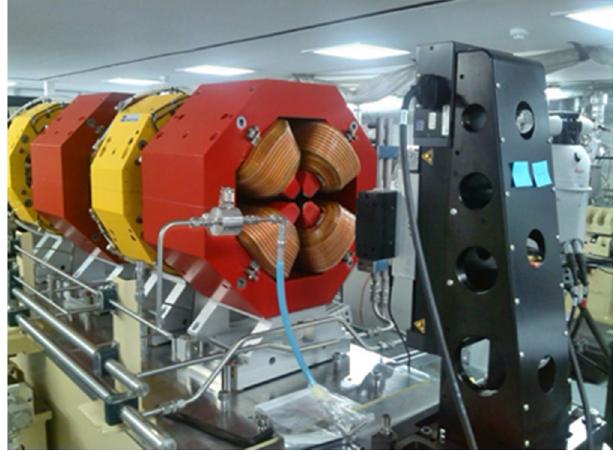
FIG. 8. Alignment of the magnets on the final girder with the stretched wire. One of the two towers of the stretched wire is visible on the right-hand